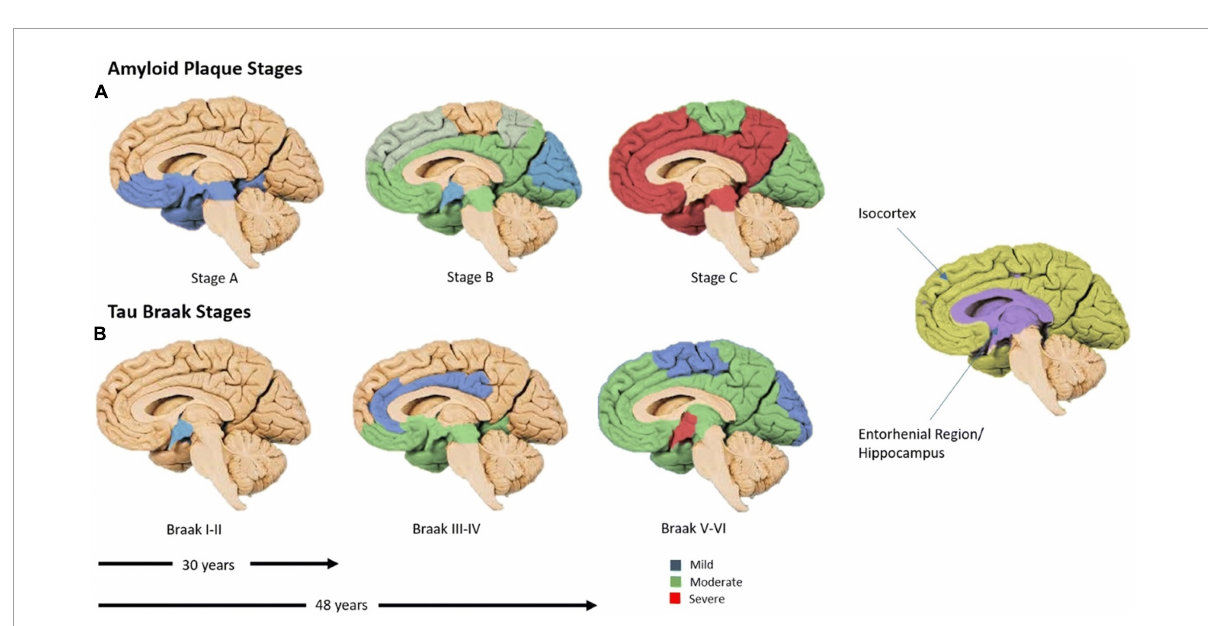
FIGURE2 The time-course of amyloid- β and tau spread. (A) Amyloid- β spread, global by 30 years. (B) Regional spread of tau. The predominant appearance of tau in the temporal lobe before spreading outwards in cell-to-cell contacts (Spotorno et al., 2020). Six Braak stages (I–VI), tau burden, begins in the trans-entorhinal region (I–II), moves to the entorhinal region (III), then into the CA1 hippocampus (IV), before moving into almost all regions of the hippocampus and isocortex (V). Finally, these regions become severely affected (VI). Blue corresponds with mild tau burden, green with moderate and red with severe (Braak and Braak, 1991). Figure from Swarbrick et al. (2019).